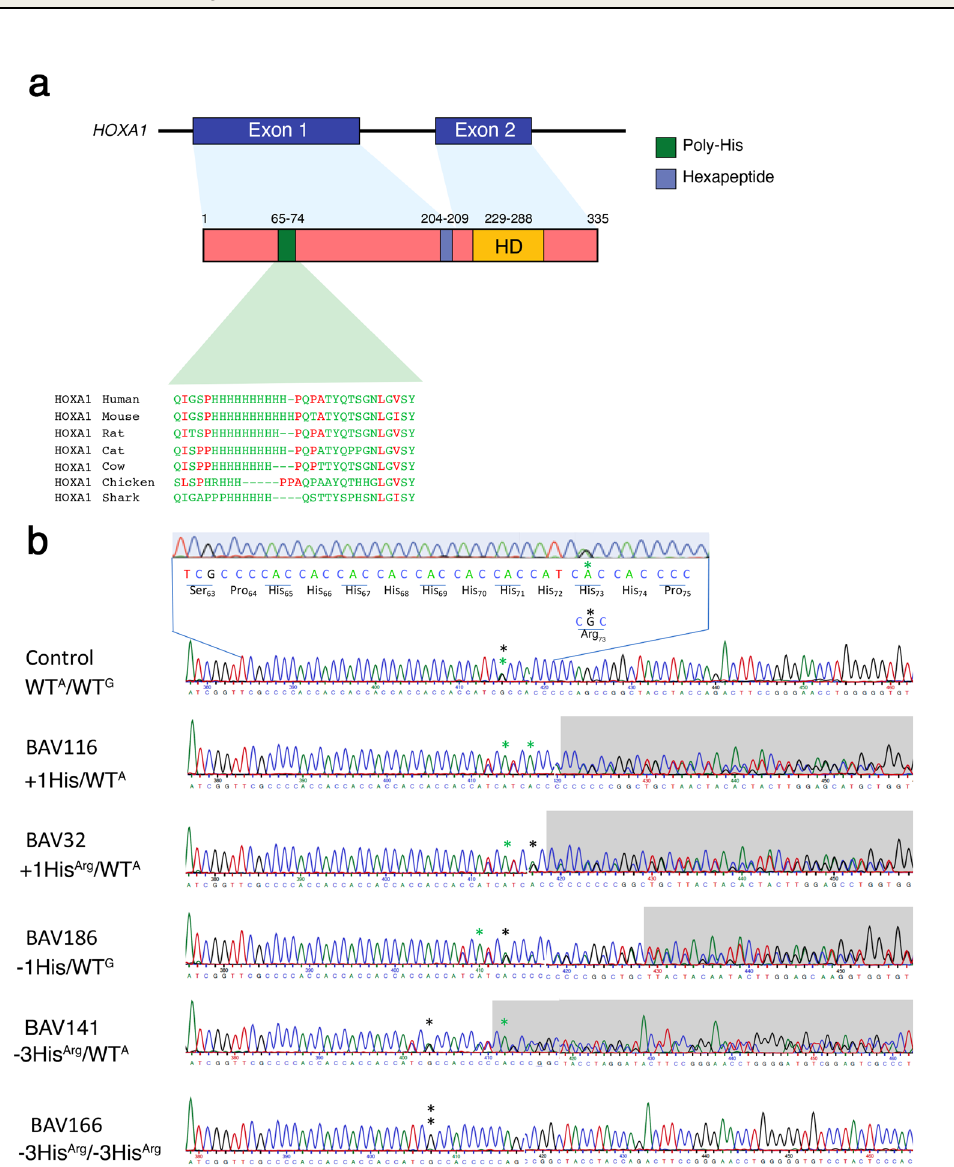
Fig. 1 | Identi fi cation of HOXA1 variants in index cases with BAV. a Schematic representation of the human HOXA1 gene and corresponding predicted protein. TheHOXA1proteincontainsthehistidinerepeatmotif(green;aminoacids65 – 74), the hexapeptide motif involved in the interaction with PBX proteins (blue; amino acids 204 – 209), encoded in exon 1, and the DNA-binding homeodomain (HD; yellow;aminoacids229-288),encodedinexon2.AlignmentoftheHOXA1histidine repeatsequences from the human, mouse, rat, cat, cow, chickenand sharkspecies is represented. The NCBI GenBank accession numbers that were utilized for the